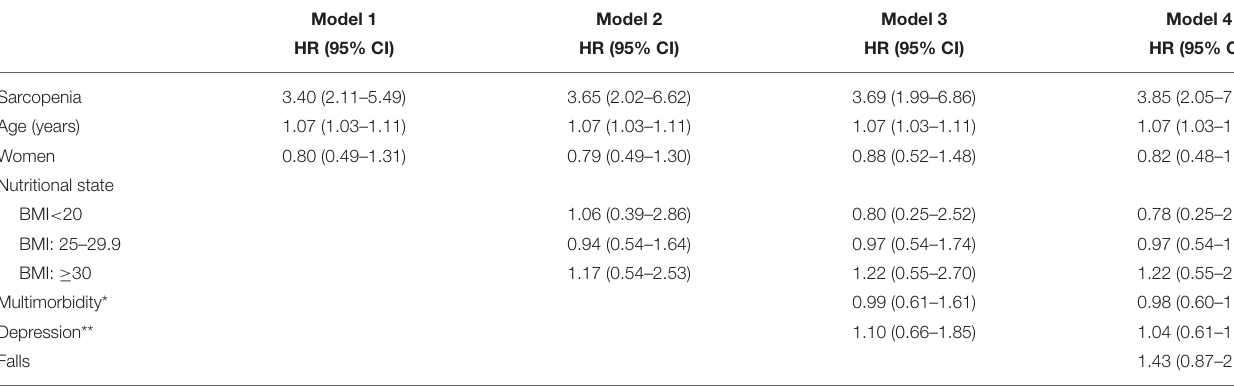
TABLE 3 | Hazard ratio of functional limitation among Chilean older people from the Alexandros and HTS Mayor studies,